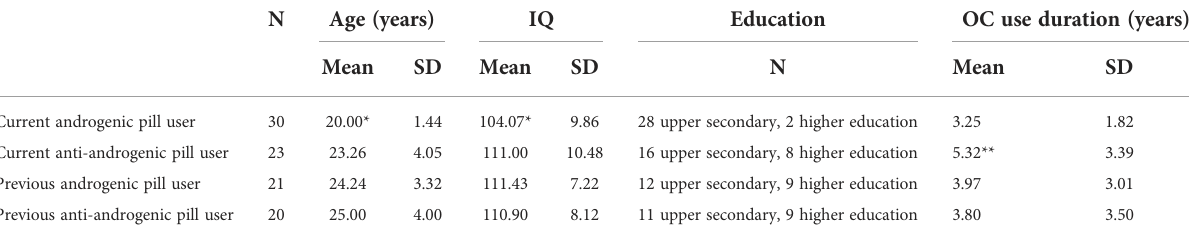
TABLE 1 Demographics between past/current and androgenic/anti-androgenic OC